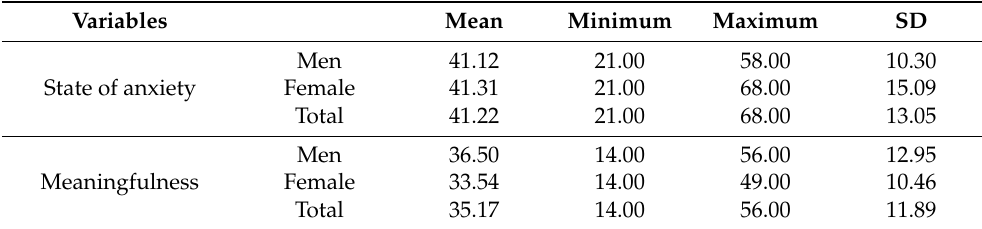
Table 1. Descriptive statistic of variables.